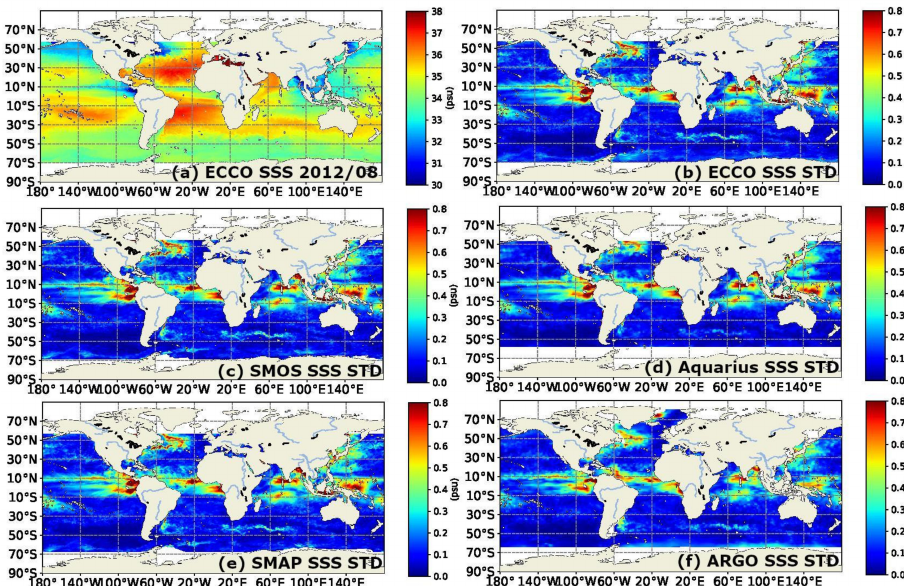
Figure 2. ( a ) August 2012 map of ECCO (1/48 ◦ ) SSS, and maps of 1 year (November 2011–October 2012) standard deviation of monthly SSS ( b ) from ECCO and for the simulated L3 ( c ) SMOS (0.25 ◦ ), ( d ) Aquarius (1 ◦ ), ( e ) SMAP (0.25 ◦ ) and ( f ) Argo-based (1 ◦ ) gridded